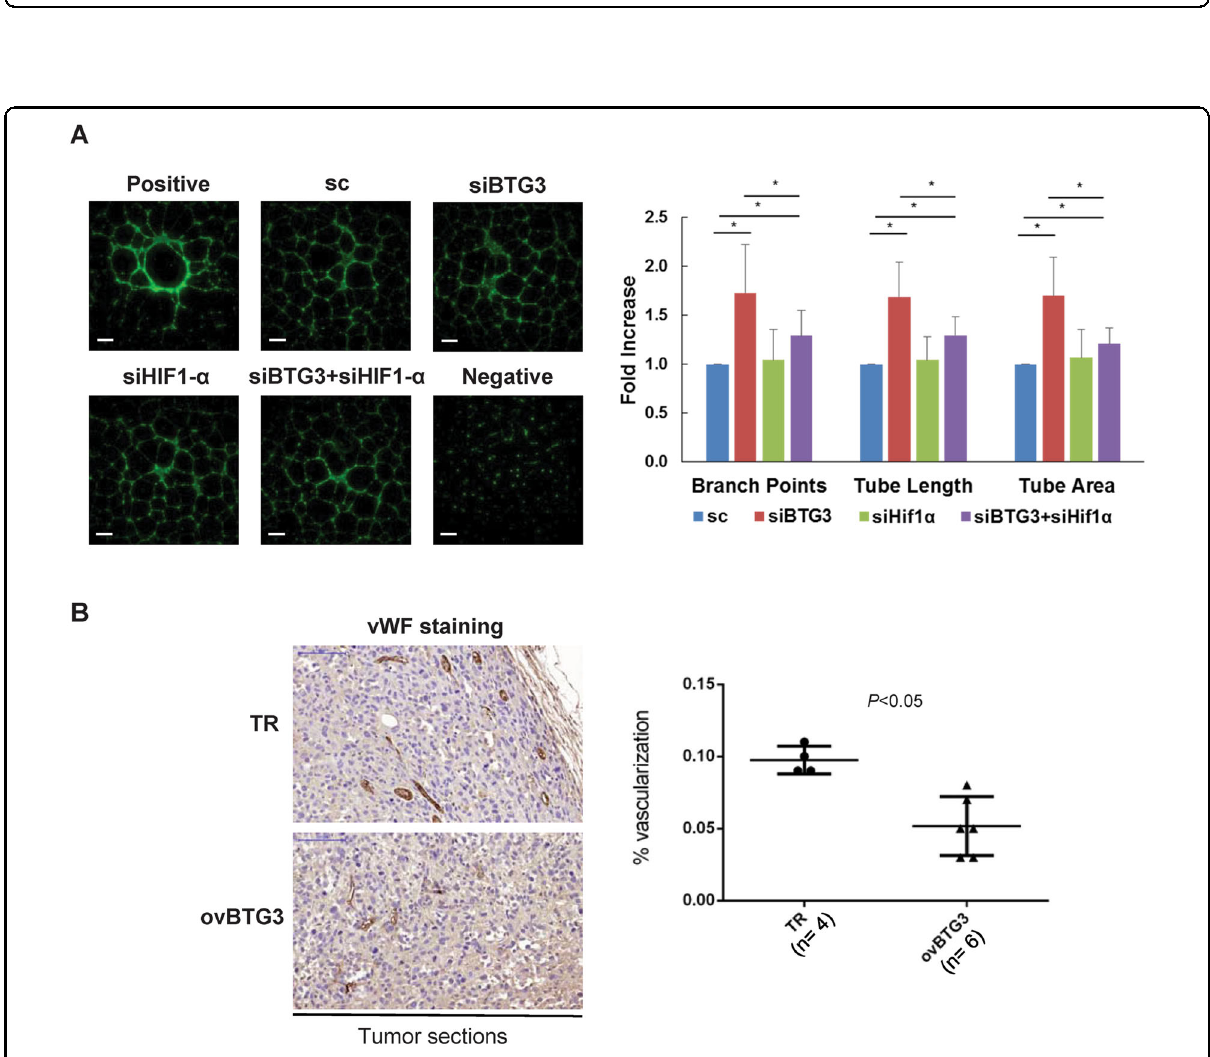
Fig. 5 Regulation of blood vessel formation by BTG3 in vitro and in vivo. a HIF-1 α is involved in the enhanced HUVEC tube formation conditioned by BTG3 knockdown. HUVEC tube formation assay was conducted with conditioned medium (CM) from IMR-90 cells transfected with control, BTG3 siRNA, HIF-1 α siRNA, or both. Scale bar, 500 μ m. Quanti fi cation was done as in ( d ). Mean ± SD from 3 independent experiments is shown. *, P < 0.05. b Overexpression of BTG3 inhibits angiogenesis in mouse xenograft tumor. Tumors were produced by injection of control (TR) or BTG3 overexpressing PC3 cells (ovBTG3) 22 . Angiogenesis was detected with immunohistochemical staining using the antibody recognizing the endothelial marker vWF. Scale bar, 100 μ